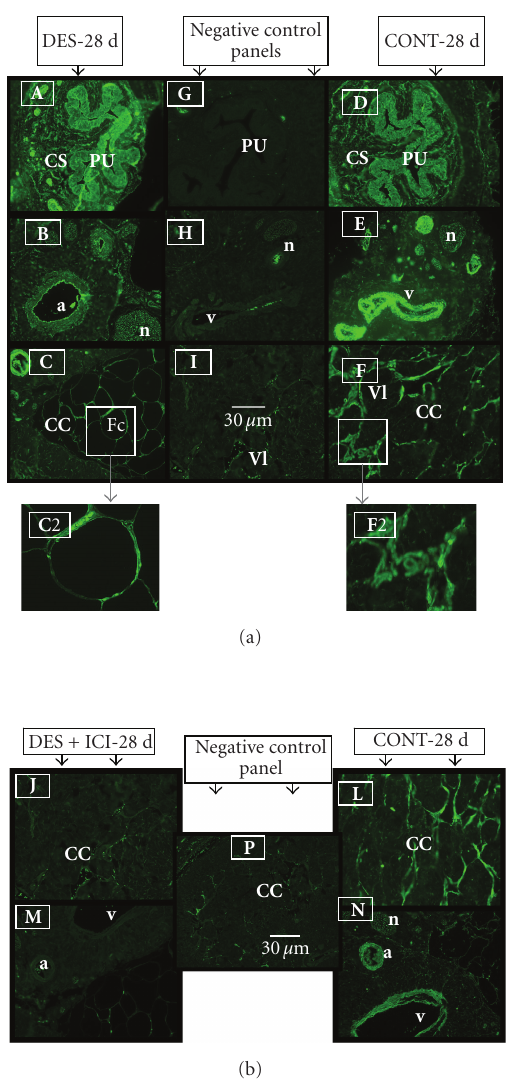
Figure 6: (a) Representative immunohistochemical staining for PPAR γ protein in the body of the penis of 28-day-old DES-treated (A), (B), and (C) and control untreated rats (D), (E), and (F). Note that PPAR γ protein is expressed in DES-treated (DES-28 d) and normal rats (CONT-28 d) with increased intensity and fat cells in DES-treated rats (see panel (C)). Note expression in transitional epithelium of the penile urethra (PU) and the surrounding corpus spongiousm (CS) in (A) and (D) and in the endothelium of blood vessels and smooth muscle cells in the dorsal artery (a) and vein (v), and in nerve fibers of the dorsal nerve (n) of the penis (B) and (E). Similar staining intensity can be seen in the endothelium and smooth muscles of the vascular lacunae (Vl) in the corpus cavernosum penis (CC) in control normal rats (F). Note one contrasting di ff erence is that the cavernous spaces in DES-treated rats in panel (C) are replaced with fat cells (Fc) that show increased staining intensity in the cell nucleus located at cell periphery. Panels (C2) and (F2) show a closer view of area outlined by insert box. Control sections (minus primary antibody) were in panels (G), (H), and (I). Scale bar = 30 μ m. (b) IHC staining for PPAR γ protein was significantly reduced by ICI 182, 780 treatment [compare staining in panels (J) and (M) with (L) and (N)]. Panel (P) is a negative control (minus primary antibody). Scale bar 30 μ